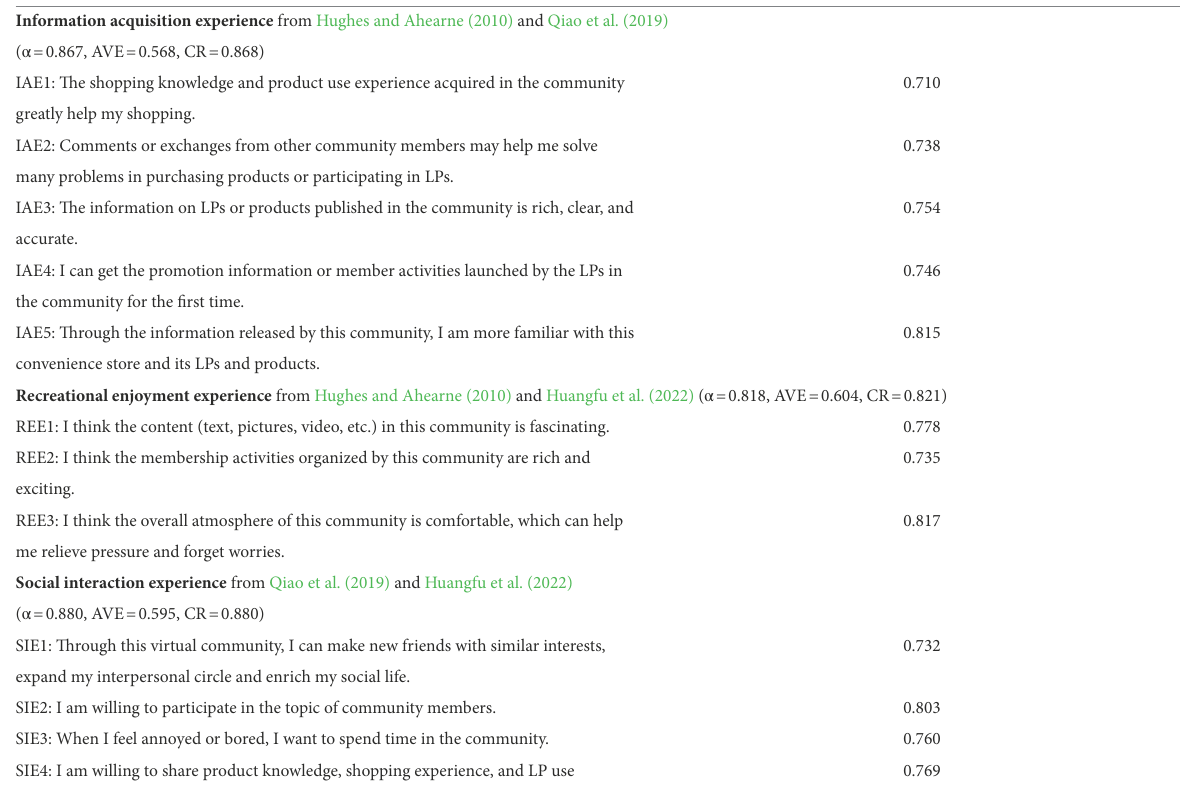
TABLE 2 Reliability and validity tests of variables. Constructs and